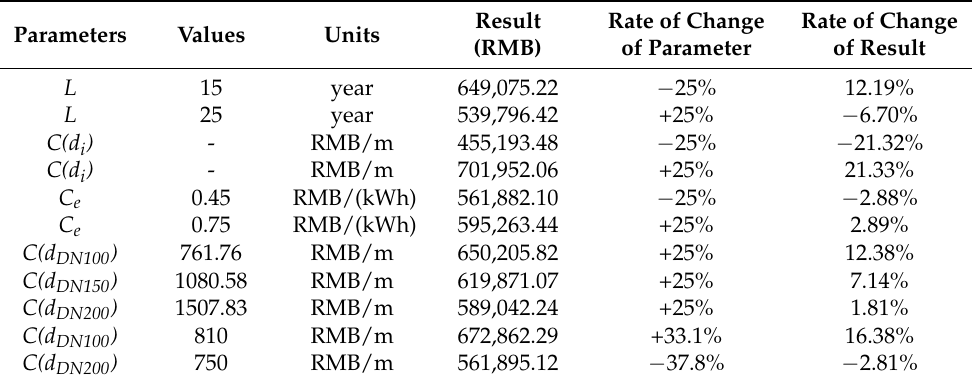
Table 3. The effect of changing parameters on the results.